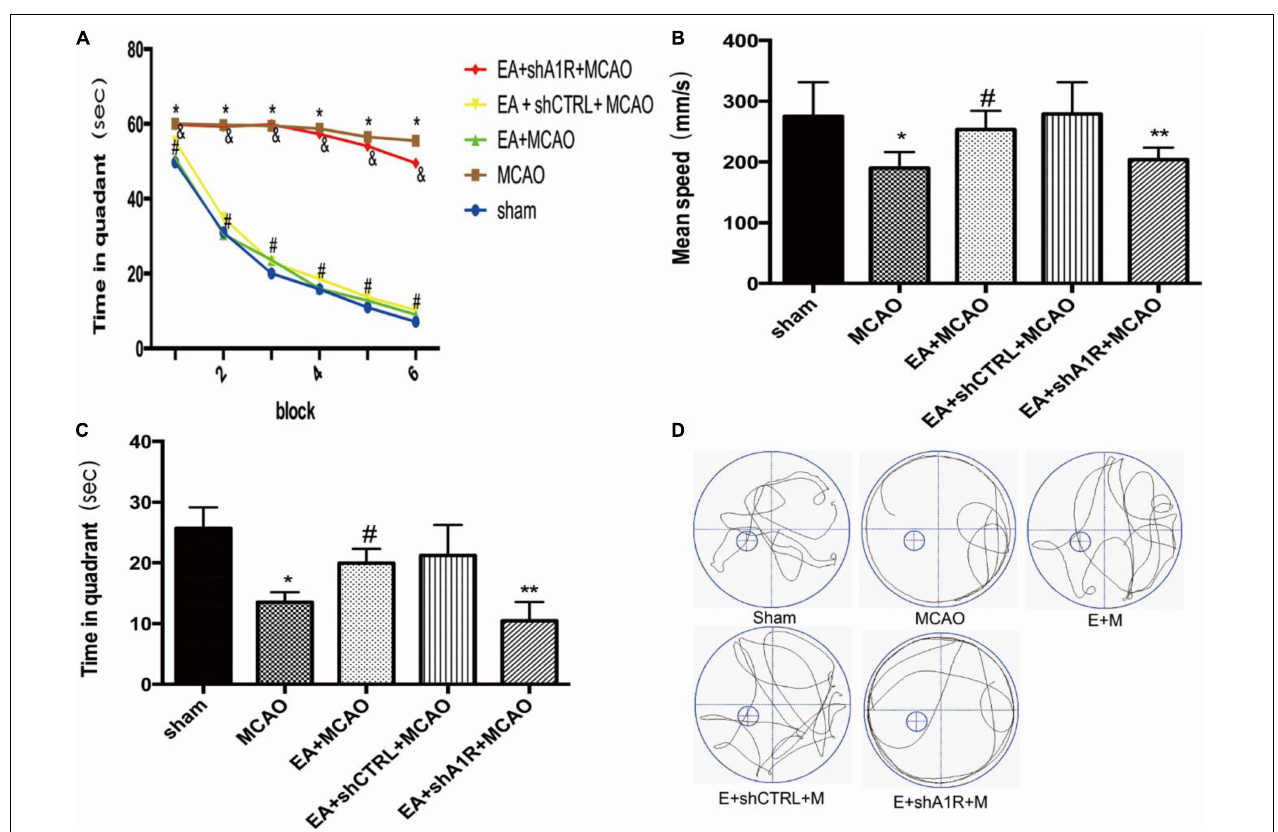
FIGURE 8 | Effects of electroacupuncture (EA) on cognitive function ( n = 6). (A) EA pretreatment decreases the escape latencies in all trials; this is reversed by AV-shA1R; (B,C) effects of EA pretreatment with AV-shA1R on (B) mean speed and (C) time in quadrant. (D) The swimming tracks of rats in different conditions in the probe trial test. * P < 0.01 vs. the sham group, # P < 0.05 vs. the MCAO group, ** P < 0.05 vs. the MCAO group, & P < 0.05 vs. the EA + MCAO group, ** P < 0.05 vs. the EA + MCAO